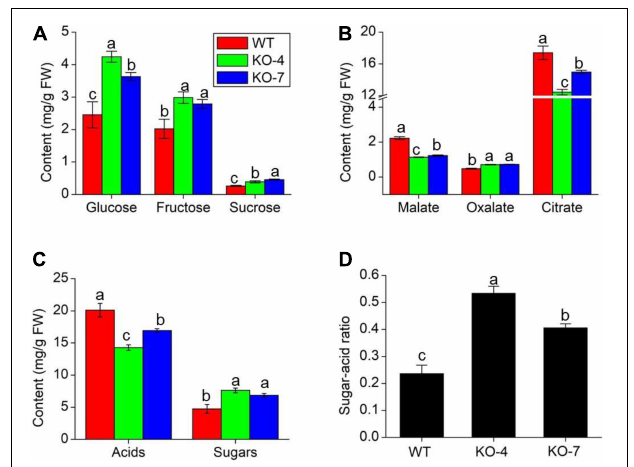
FIGURE 6 | Fruit quality analysis of MT species between WT and mutants at RR stage. Main sugars (A) , acids (B) , total sugars and acids (C) content, and sugar-acid ratio (D) in WT and mutants. Error bars indicate mean values ± SD ( n = 3). Different letters on vertical bars indicate significant difference at p < 0.05 using one-way